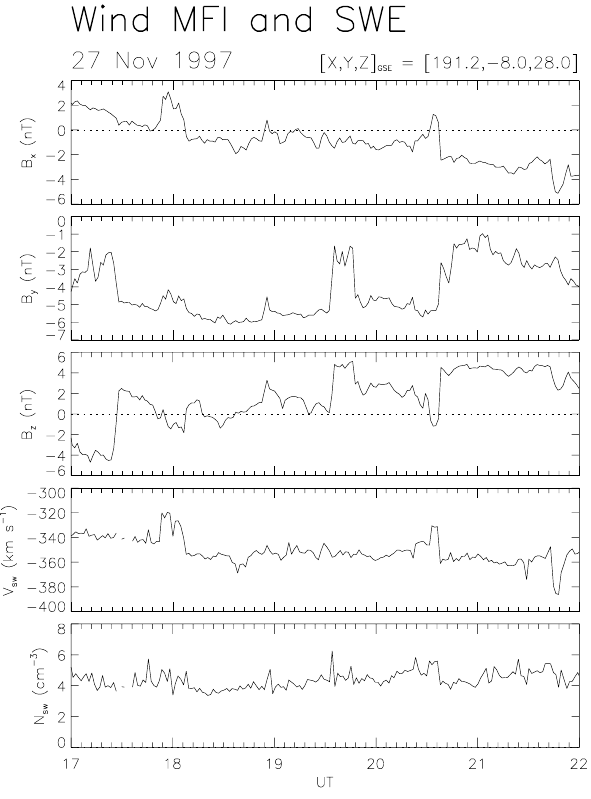
Fig. 2. Wind measurements of the IMF and solar wind velocity and density for the interval 17–22 UT on 27 November